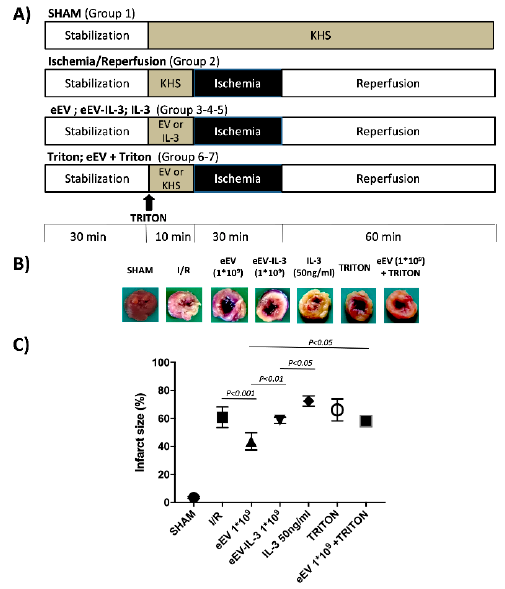
Figure 3. eEV, but not eEV-IL-3, protects isolated rat hearts from I/R-induced damage. ( A ) Timeline of ex vivo protocol . Protocols of ischemia (black boxes) and reperfusion (white boxes) in isolated rat hearts. After stabilization (white boxes), Krebs–Henseleit buffer solution (KHS) was infused alone (I/R) or with eEV, eEV-IL-3, or IL-3. eEV (1 × 10 9 ), eEV-IL-3 (1 × 10 9 ), or IL-3 (50 ng/mL) given for 10